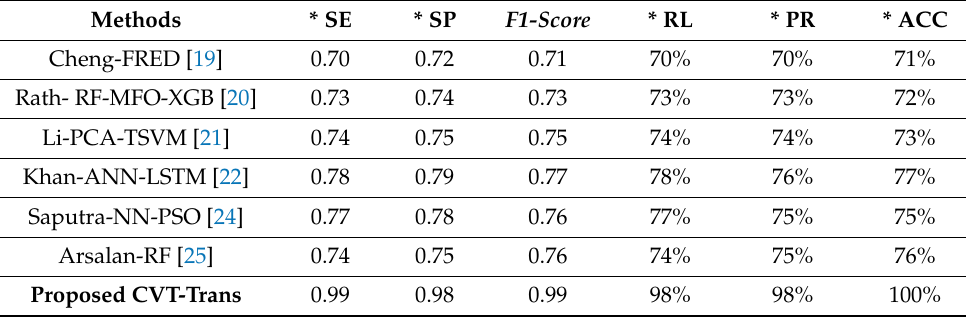
Table 7. Performance comparisons between proposed method and state-of-the-art techniques by using data augmentation, 10-fold cross validation test and by using five stages of CVD disease.